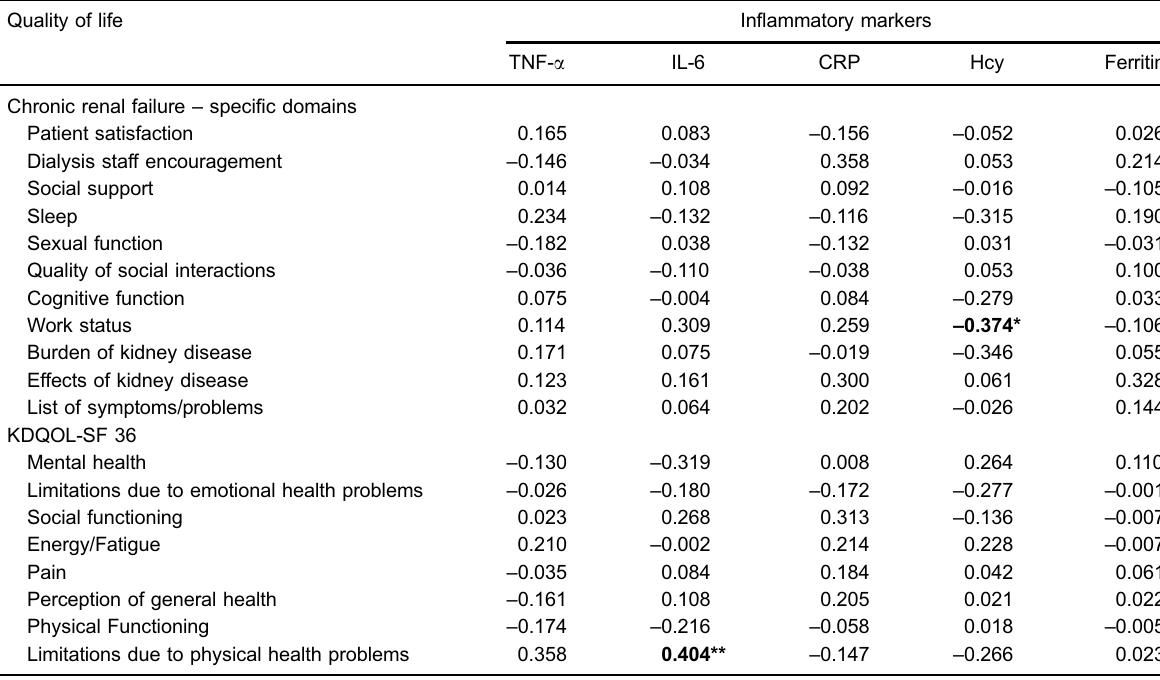
Table 3. Spearman ’ s correlation coef fi cients between quality of life and in fl ammatory markers. Quality of